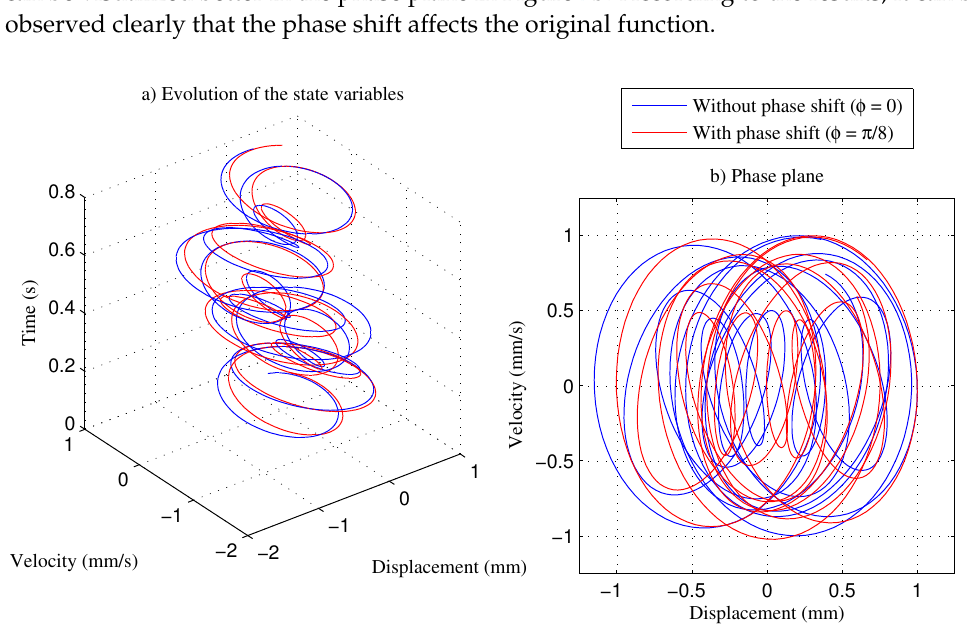
Figure 7. Evolution of the state variables and phase plane for the multiple asynchronous function of Equation (12): ( a ) without phase shift ( φ = 0); ( b ) with phase shift ( φ = π